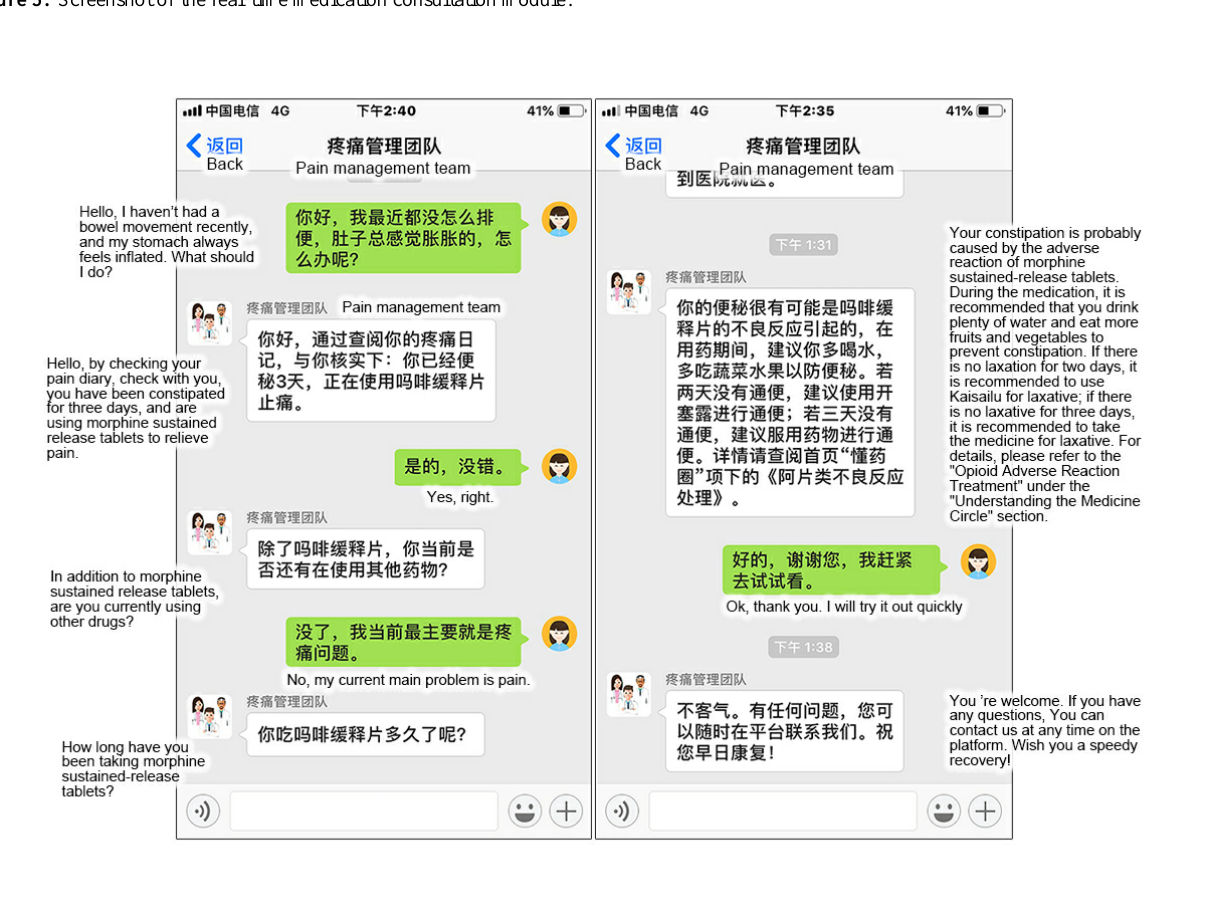
Figure 5. Screenshot of the real-time medication consultation